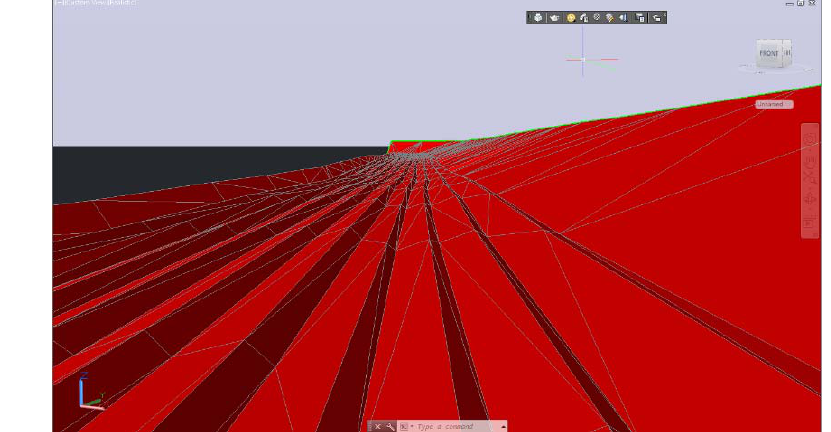
Figure 14 – Appearance of the DTM after adding the structural (course and ridge) lines Рис . 14 – Изображение ЦММ после добавления структурных линий Слика 14 – Изглед ДМТ након додавања структурних линија By visual inspection of the model and the comparison with the actual surface of the terrain (Figure 15), we can conclude that the formed DTM satisfactorily represents the real physical